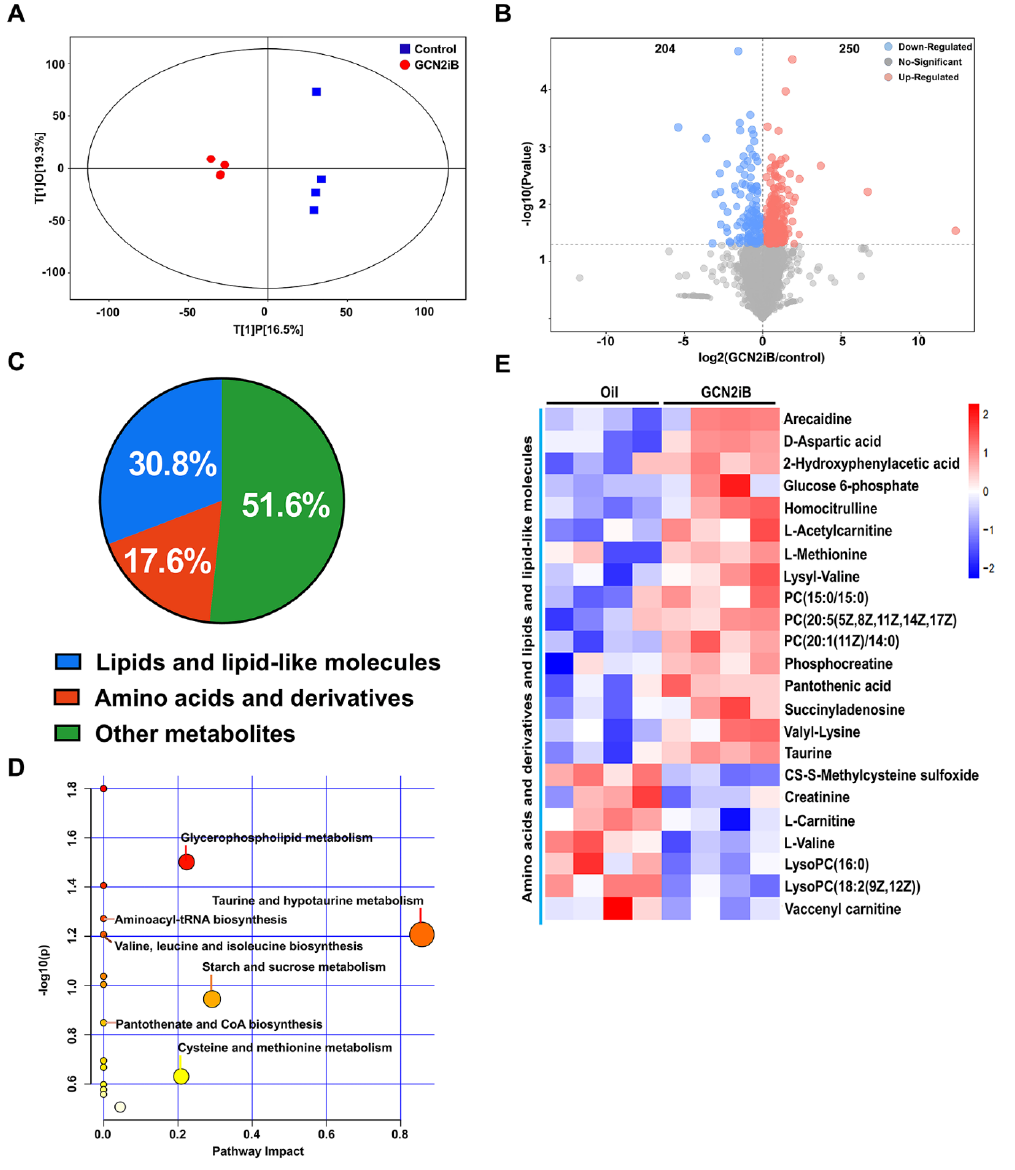
Figure 2. Effect of GCN2iB treatment on myocardial metabolomic profiles in T2D mice. ( A ) Orthogonal projections to latent structures discriminant analysis (OPLS-DA) models for the oil- and GCN2iB-treated groups are presented as score scatter plots. ( B ) The changes in myocardial metabolites in T2D mice are presented in a volcano plot. ( C ) A pie chart is used to illustrate the percentages of major metabolites of T2D mice. ( D ) KEGG pathway enrichment analysis of significantly different metabolites. ( E ) The significantly changed amino acid- and lipid-related metabolites caused by GCN2iB treatment are presented as a heatmap.